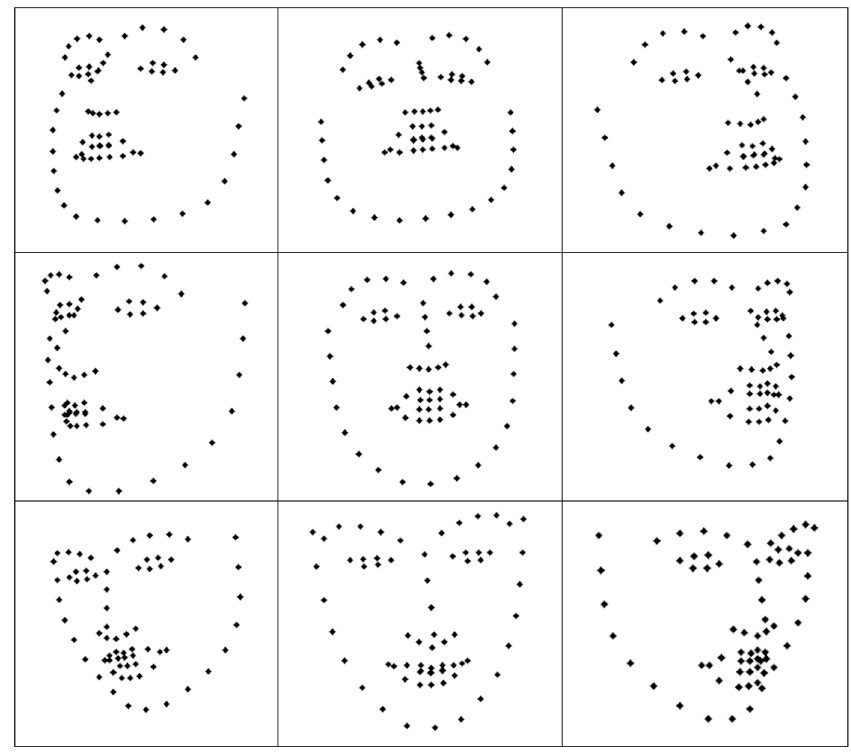
Figure 4. Typical examples of each of the nine head poses from the training